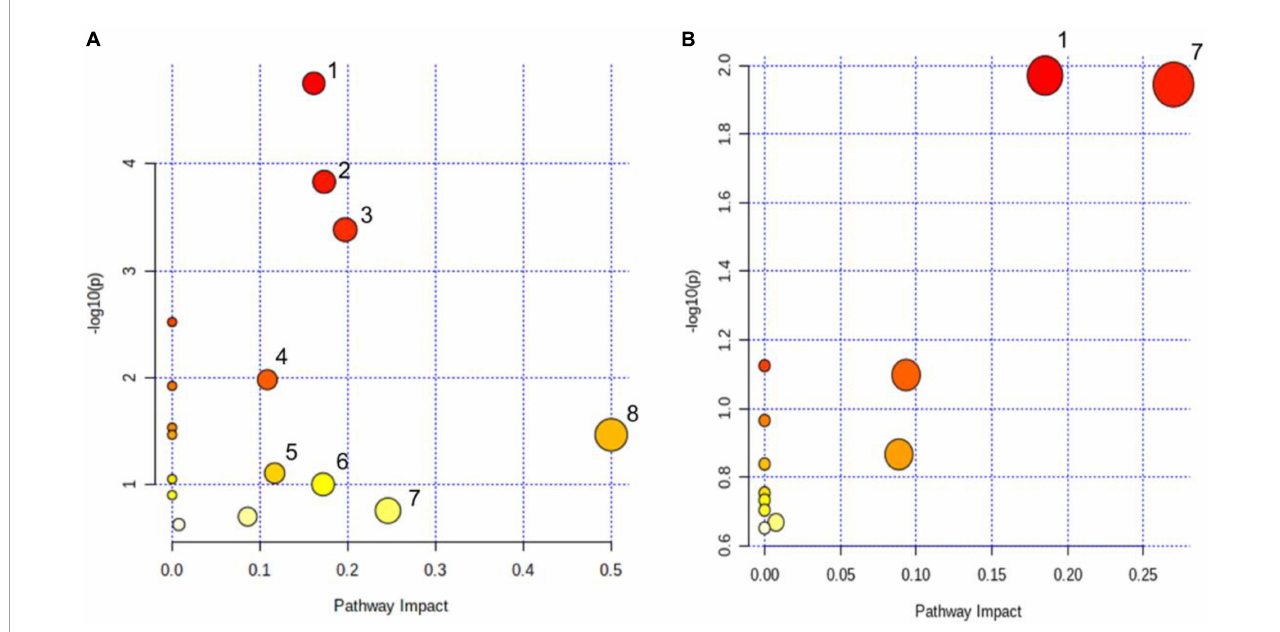
FIGURE4 Pathway analysis of urinary metabolites using metaboanalyst (impact factor ≥ 0.1). (A) Disturbed metabolic pathways in PS cDKO mice. (B) Influenced metabolic pathways of PS cDKO mice after electroacupuncture. (1) Glyoxylate and dicarboxylate metabolism, (2) citrate cycle (TCA cycle), (3) alanine, aspartate, and glutamate metabolism, (4) glutathione metabolism, (5) arginine biosynthesis, (6) pentose and glucuronate interconversions, (7) glycine, serine, and threonine metabolism, and (8) d-glutamine and d-glutamate metabolism. N =